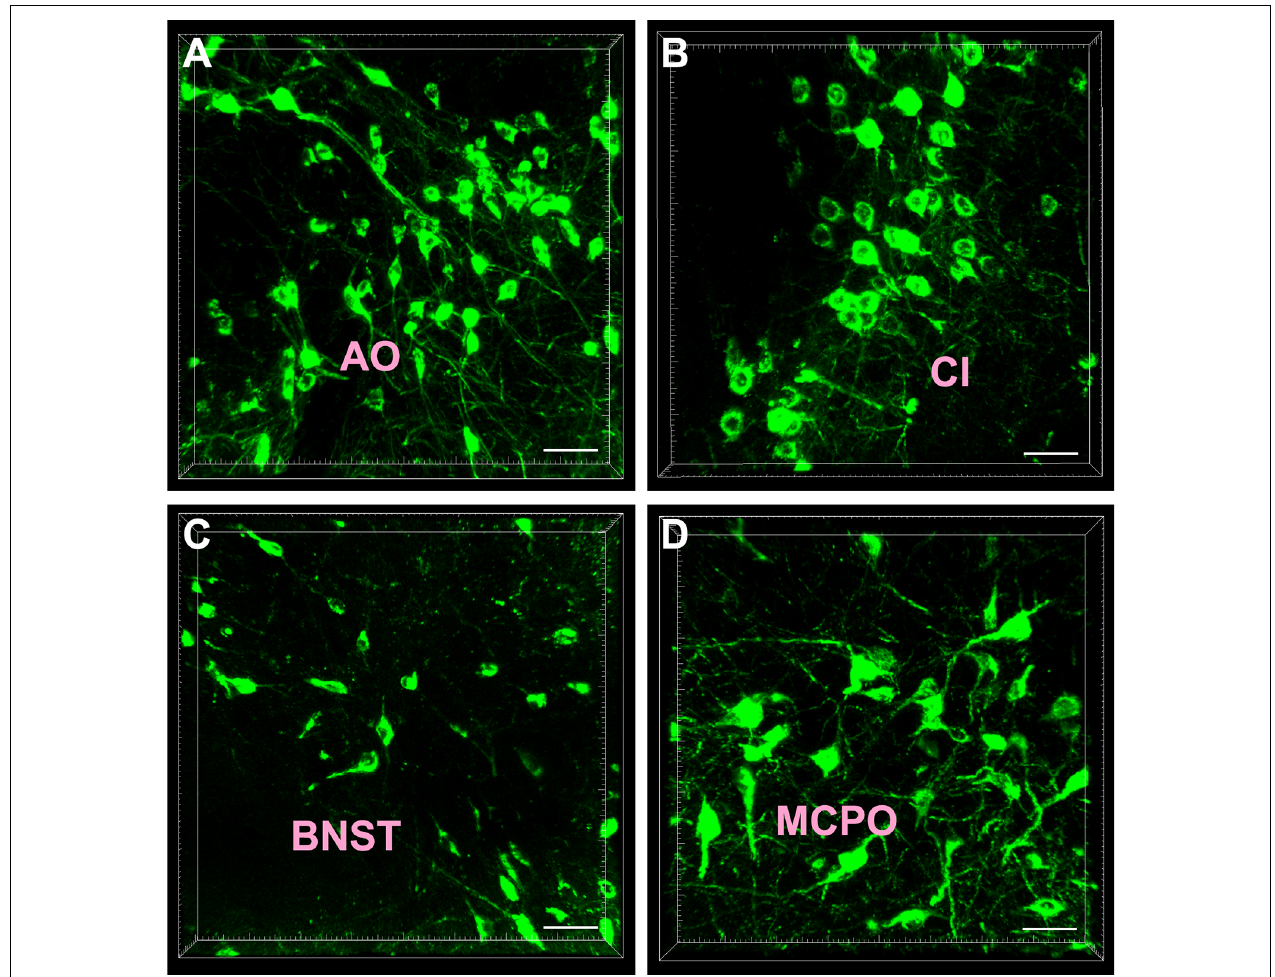
FIGURE 2 | Cellular morphology of the cholera toxin subunit B-positive neurons. The representative photographs were captured from the anterior olfactory nucleus (AO; A ) claustrum (Cl; B ) bed nucleus of the stria terminalis (BNST; C ) and magnocellular preoptic nucleus (MCPO; D ). Bar = 40 µ m.